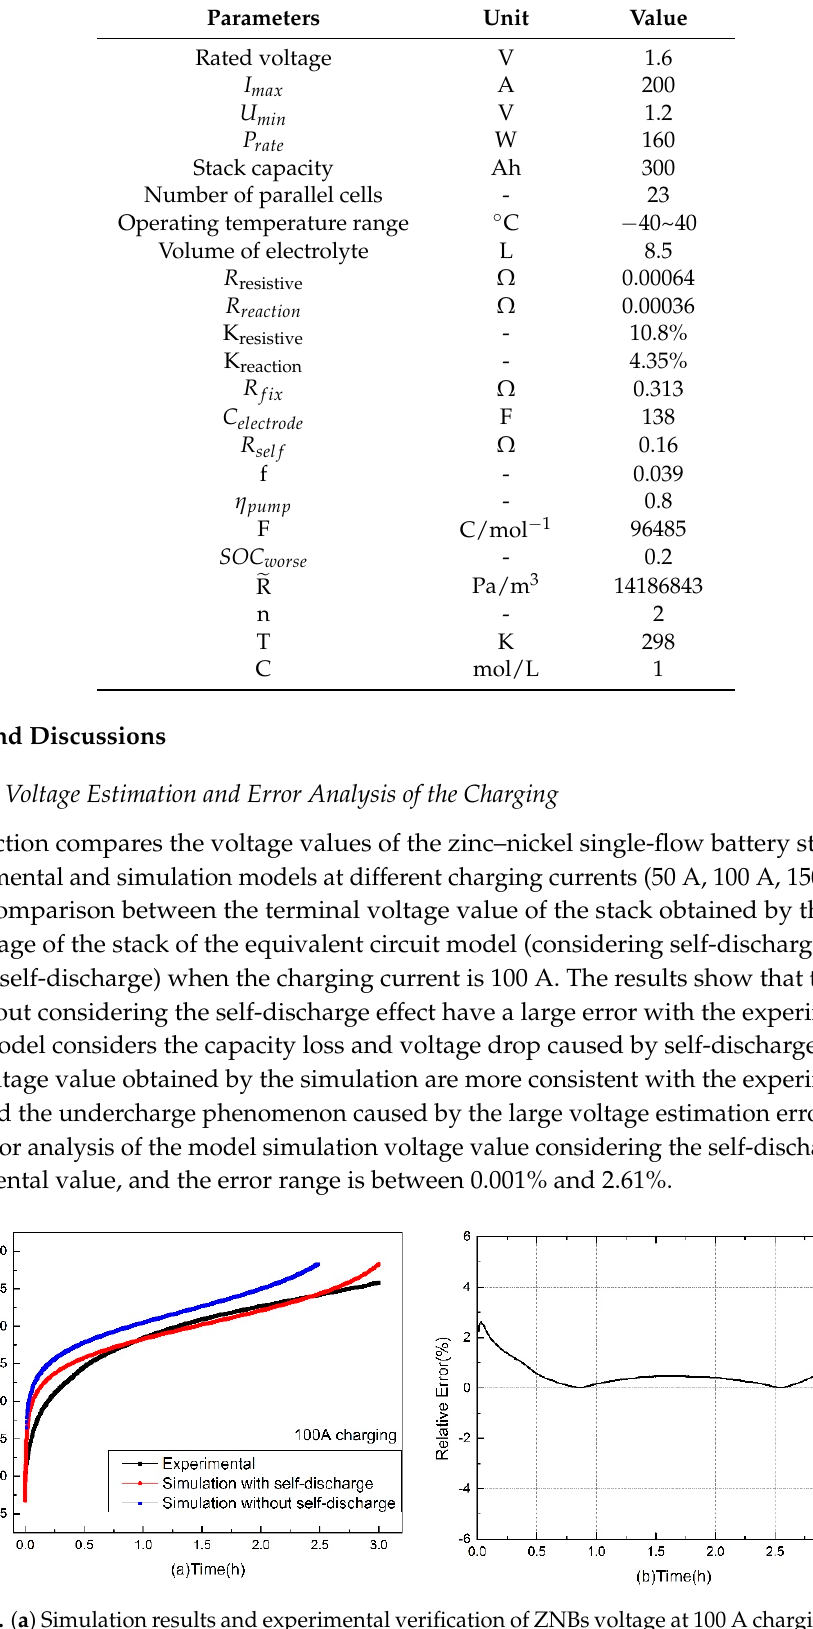
Figure 7. ( a ) Simulation results and experimental verification of ZNBs voltage at 100 A charging current; ( b ) relative error between simulation results considering self-discharge and experimental results. Figure 8. is a comparison of simulated voltage values obtained from electrical models (considering self-discharge and without considering self-discharge) with experimentally obtained voltage values at 50 A and 150 A. The results show that the simulation results considering the self- discharge are more accurate, and the error analysis is shown in Table 4.